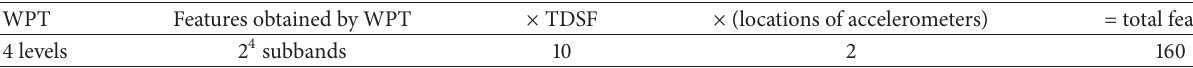
Table 4: TDSF extraction under different decomposition levels of WPT.